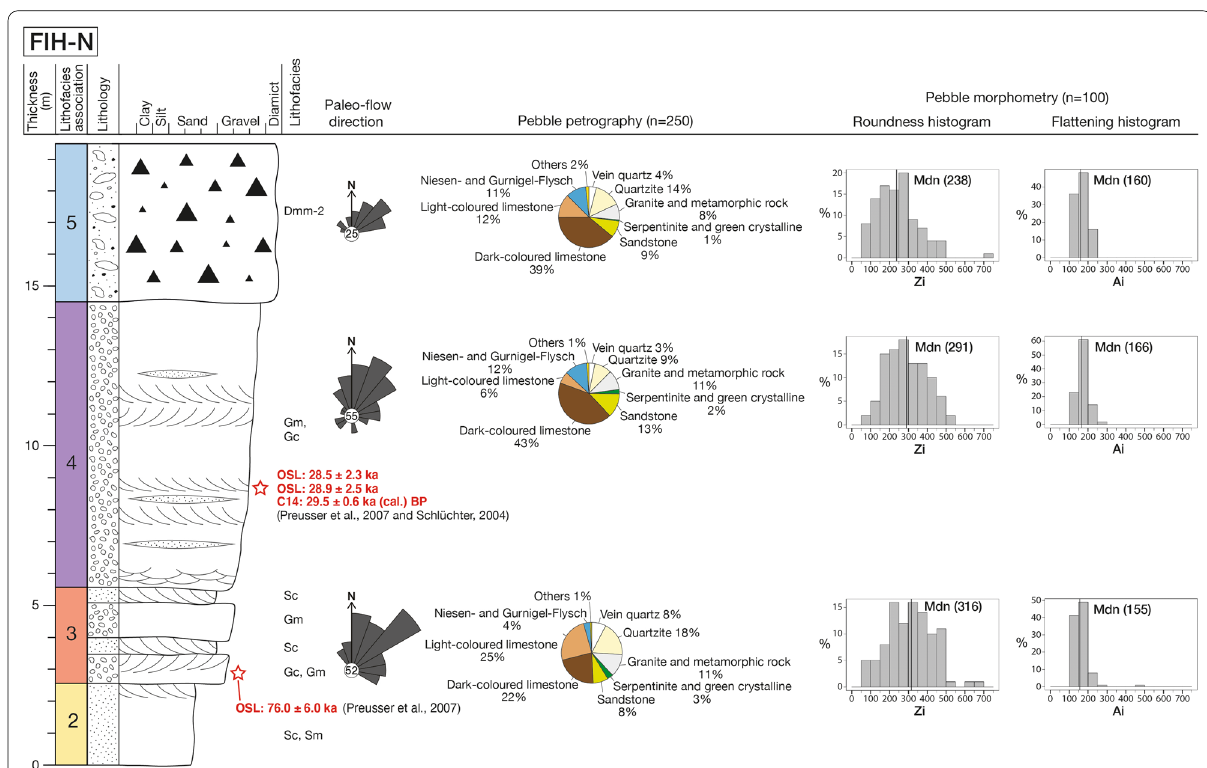
Fig. 6 Sedimentological log shows the sedimentary record at Finsterhennen northern part (FIH-N; CH1903 of LFA 5 at 466.8 m a.s.l.) with (i) lithofacies associations (LFA; Table 2), lithofacies (LF; Table 1), (ii) paleo-flow directions, (iii) pebble petrography, and (iv) pebble morphometry. Published OSL and radiocarbon (C14) ages are projected into the section and indicated as red stars. See Fig. 2 for the location of the log, and Fig. 5 for the